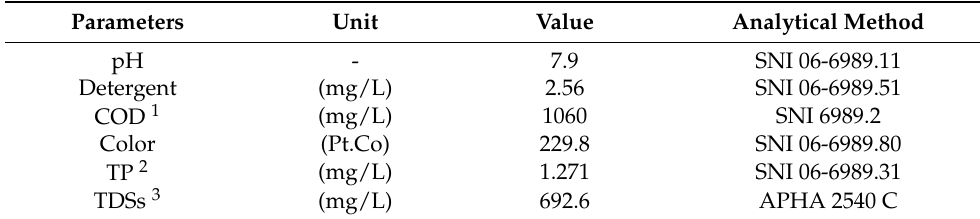
Table 2. Properties of the laundry wastewater and standard methods for their determination.